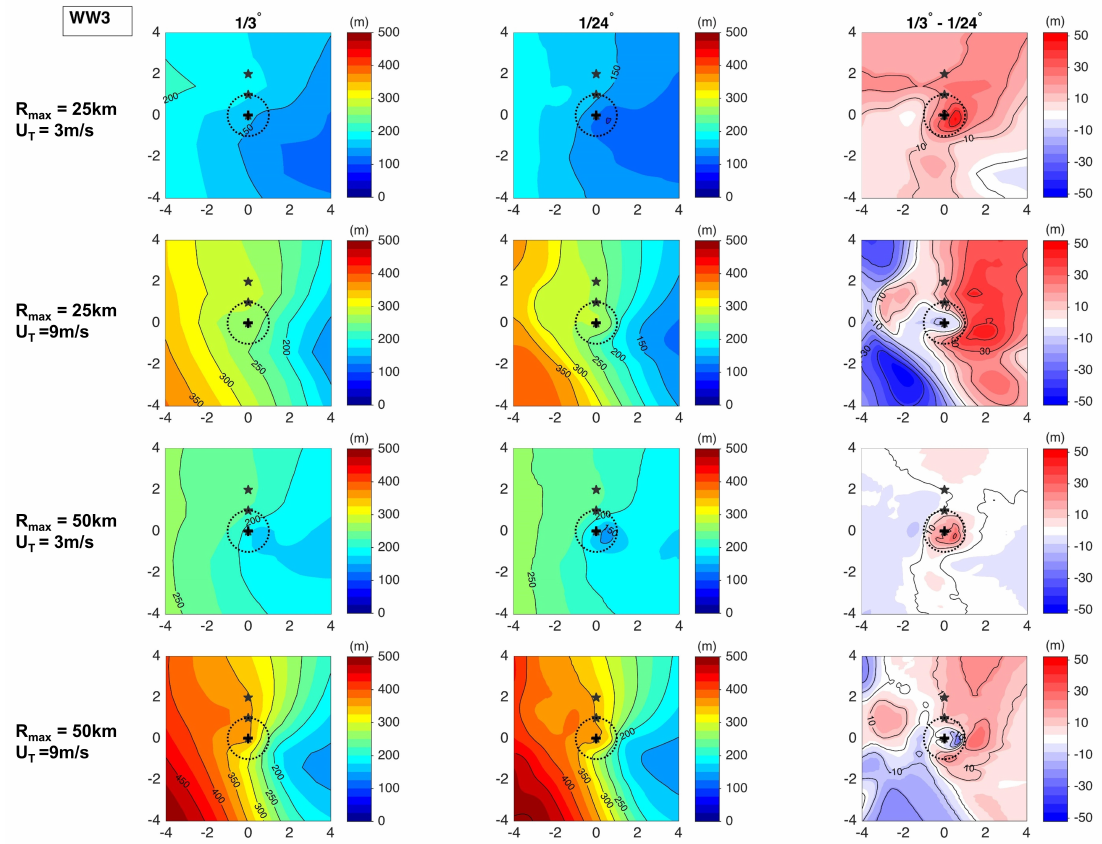
Figure 9. Spatial distribution of mean wavelength (wavelength weighted averaged by spectral density) in time-averaged quasi-steady state wave fields from WW3. The figure format is the same as Figure